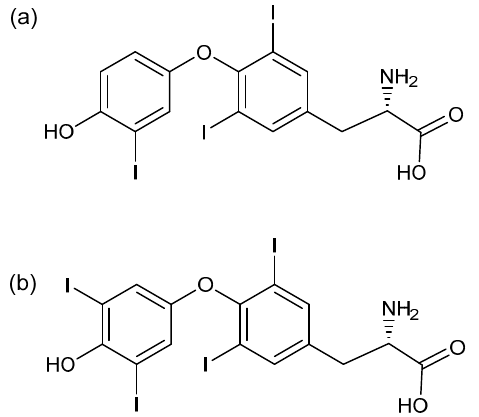
Figure 1. Chemical structure of ( a ) fT3 and ( b ) T4 hormones.